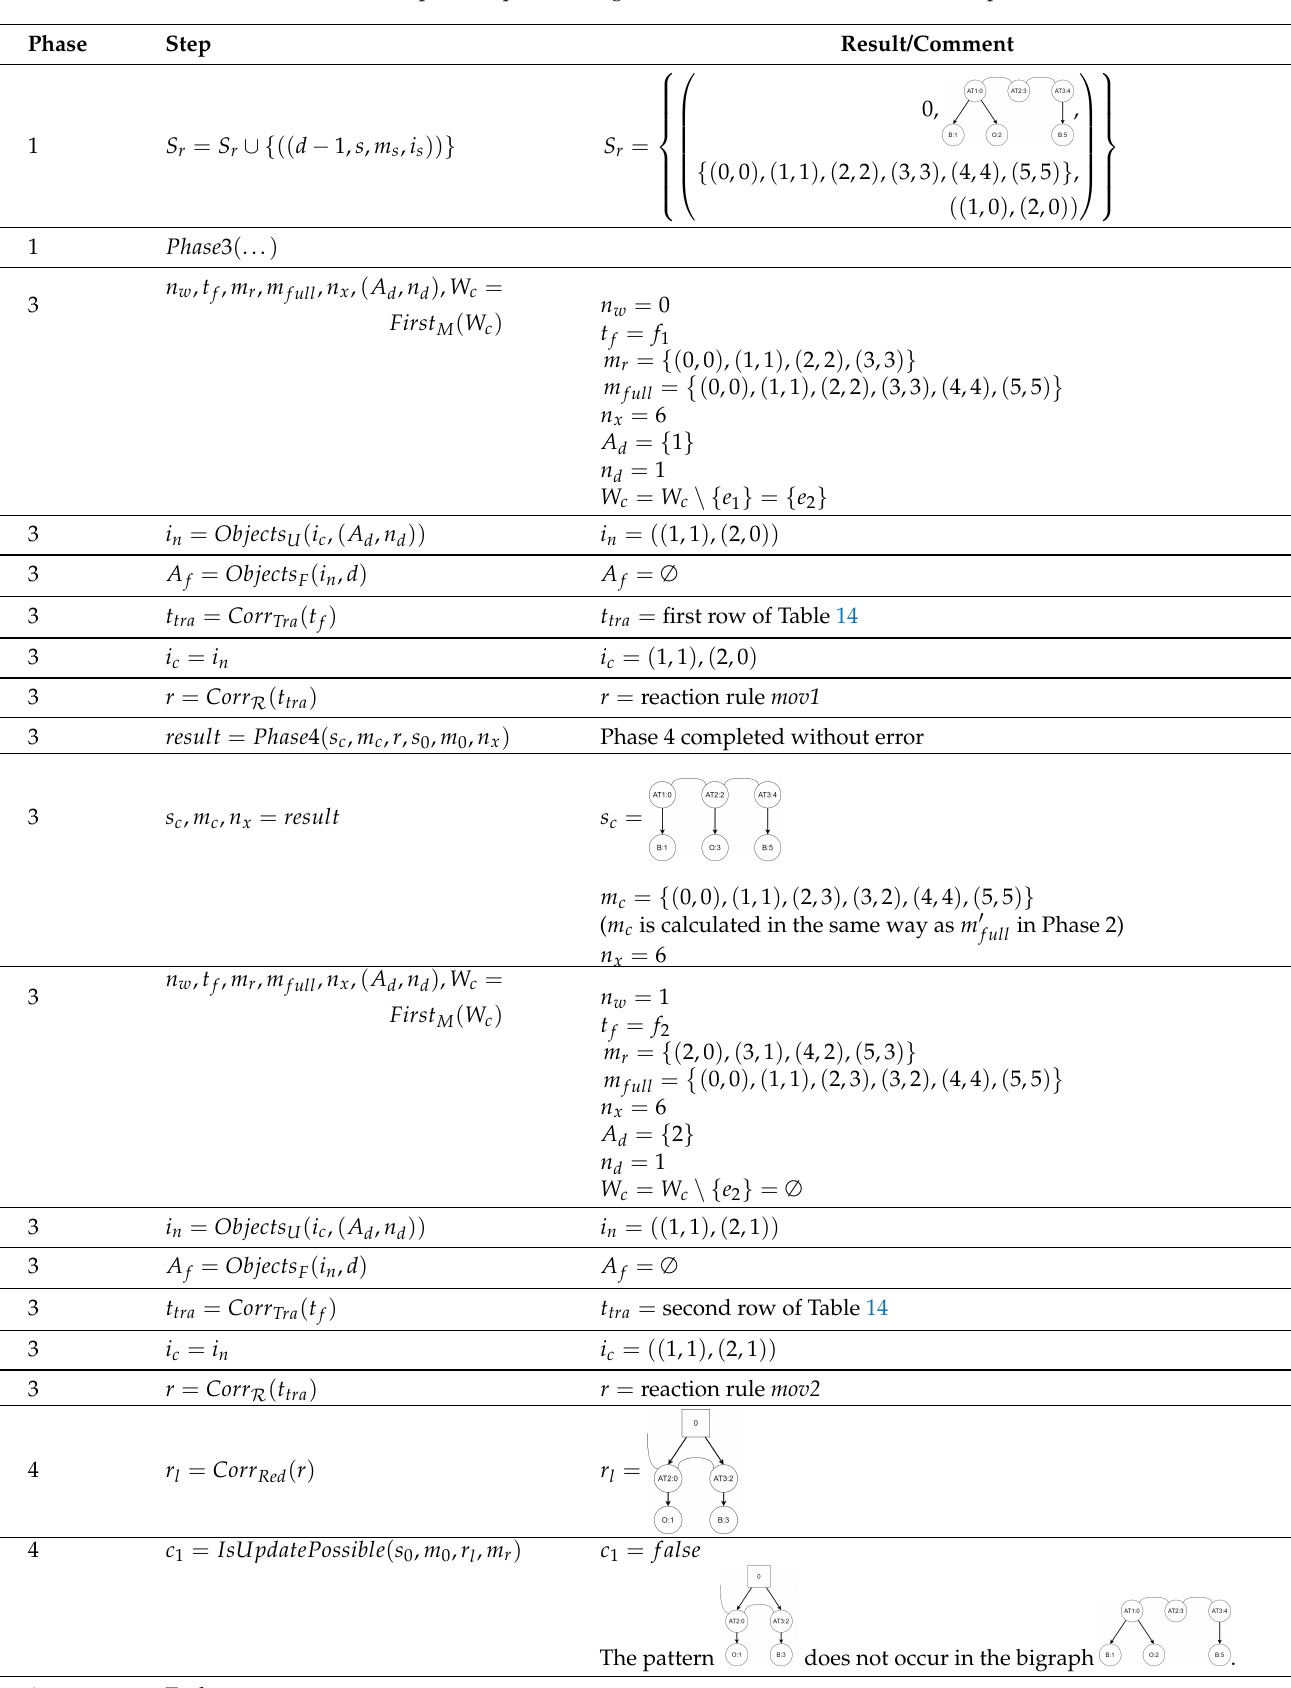
Table 16. Subsequent steps of the algorithm in the model validation